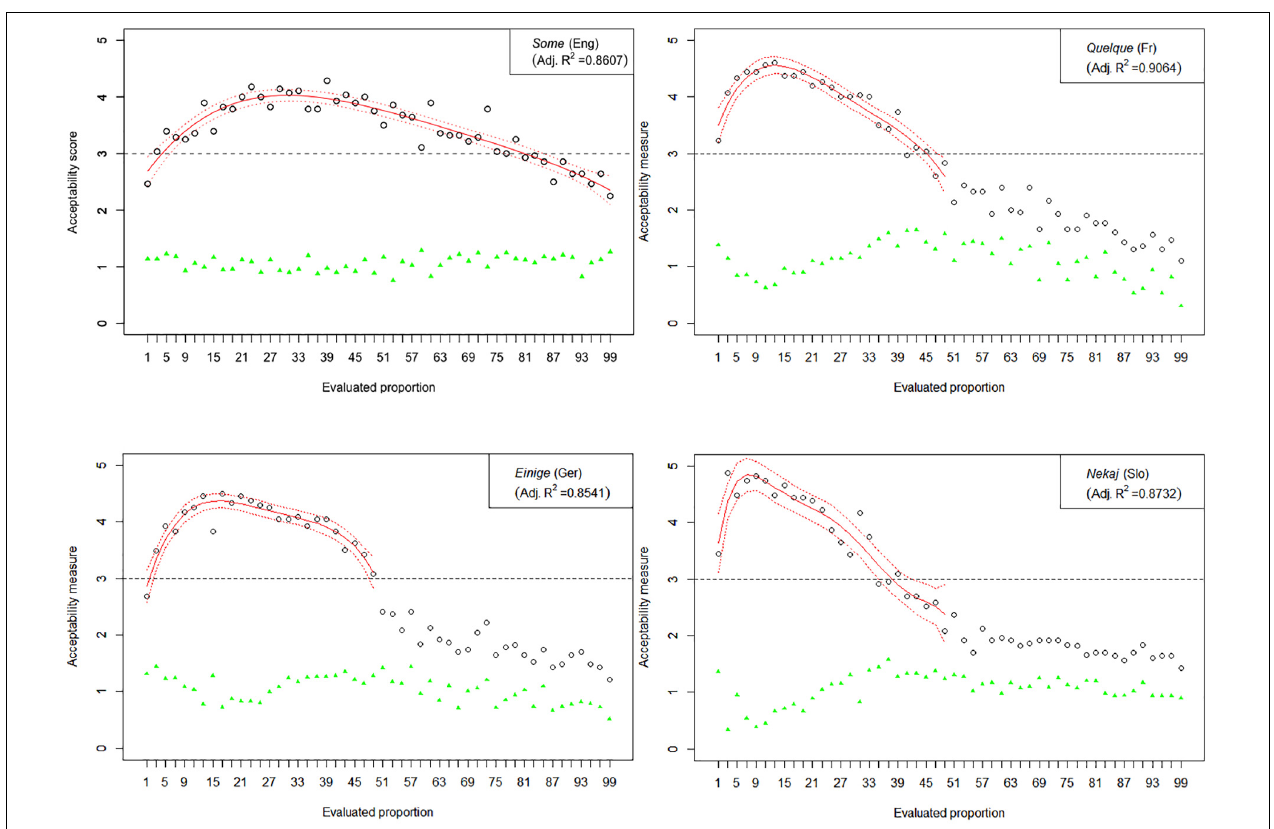
FIGURE 3 | Experiment 1: Mean acceptability scores on some and its cross-linguistic variants in the four tested languages (absolute values of standard deviation for respective means are shown in green), together with respective polynomial fit curves and confidence intervals predicting acceptability in the upper half of the Likert